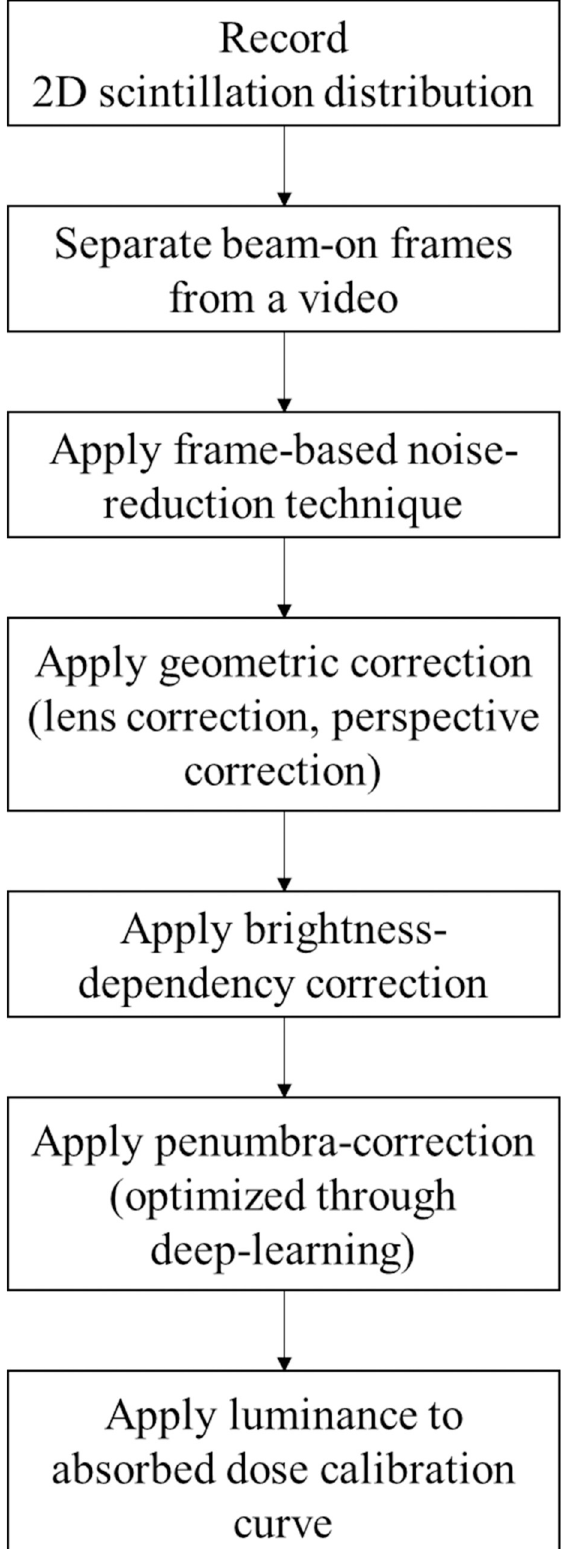
Fig 8. Flowchart for measuring 2D dose distribution using the TRMLSD. https://doi.org/10.1371/journal.pone.0246742.g008 PLOS ONE | https://doi.org/10.1371/journal.pone.0246742 February 12,